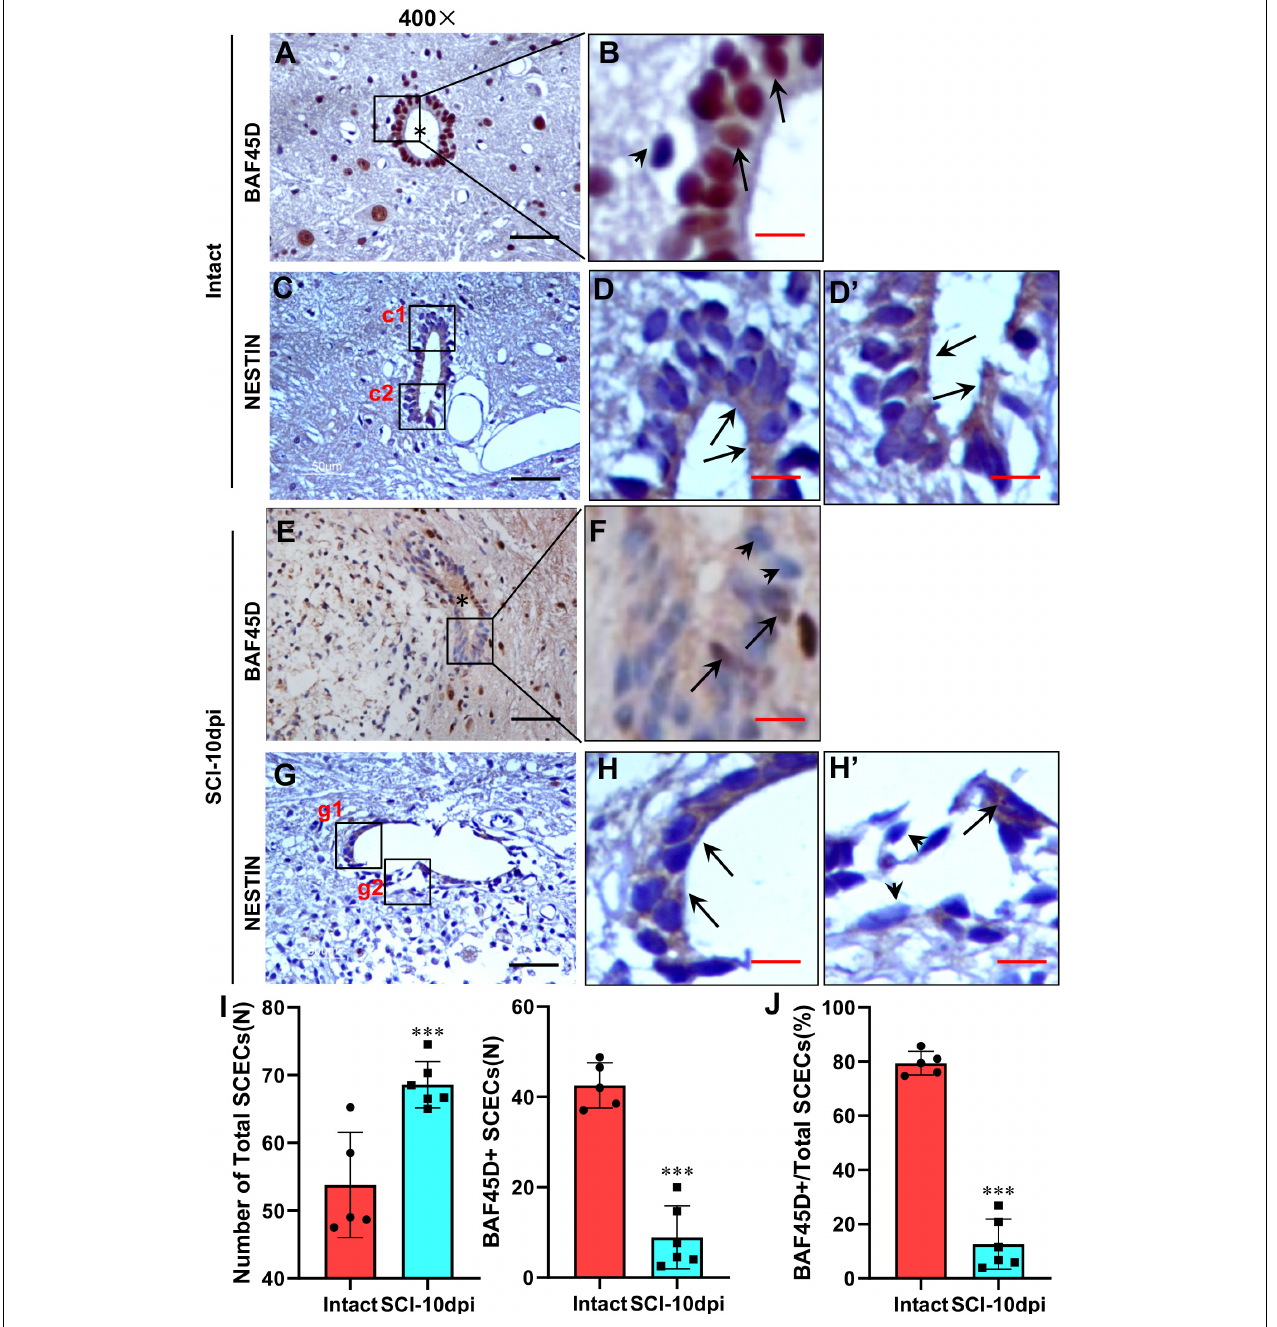
FIGURE 5 | Downregulation of BAF45D in SCECs following SCI in adult rats. (A,B) Expression of BAF45D in the SCECs of intact spinal cord. (B) Represents a 2000 × magnification of the inset shown in (A) . Asterisks indicate CC (A) while arrows indicate BAF45D-positive nuclei in SCECs. (C–D’) Expression of NESTIN in the SCECs of intact spinal cord. (D,D’) Represent 2000 × magnification of insets c1 and c2 shown in (C) . Arrows indicate NESTIN-positive cytoplasm. (E,F) Expression of BAF45D in the SCECs of injured spinal cord. (F) Represents a 2000 × magnification of the inset shown in (E) . The asterisk indicates injured CC (E) while arrows indicate BAF45D-positive nuclei; the arrowheads indicate BAF45D-negative nuclei in ependymal cells (F) . (G–H’) Expression of NESTIN in the SCECs of injured spinal cord. (H,H’) Represent higher magnifications of insets g1 and g2 shown in (G) . The arrows indicate NESTIN-positive cytoplasm. The arrowheads indicate little or no expression of NESTIN. Scale bars: 25 µ m (A,C,E,G) and 5 µ m (B,D,D’,G,H,H’) . (I,J) Tissue sections from five rats ( n = 5) in the intact group and six rats ( n = 6) in the SCI-10dpi (days post-injury) group were quantified using Image J software. Statistical analysis of the total numbers of SCECs and the proportion of BAF45D-positive cells in SCECs before and after SCI are shown (I) . Data represent mean ± SD. Statistical analysis involved one-way ANOVA and was carried out using SPSS 17.0 software. The proportion (%) of BAF45D-positive cells among the total number of SCECs in intact and injured spinal cords are shown (J) . Data represent mean ± SD. Statistical analysis involved the Mann–Whitney U -test and was carried out with SPSS 17.0 software. ∗∗∗ P < 0.01, as compared with controls.